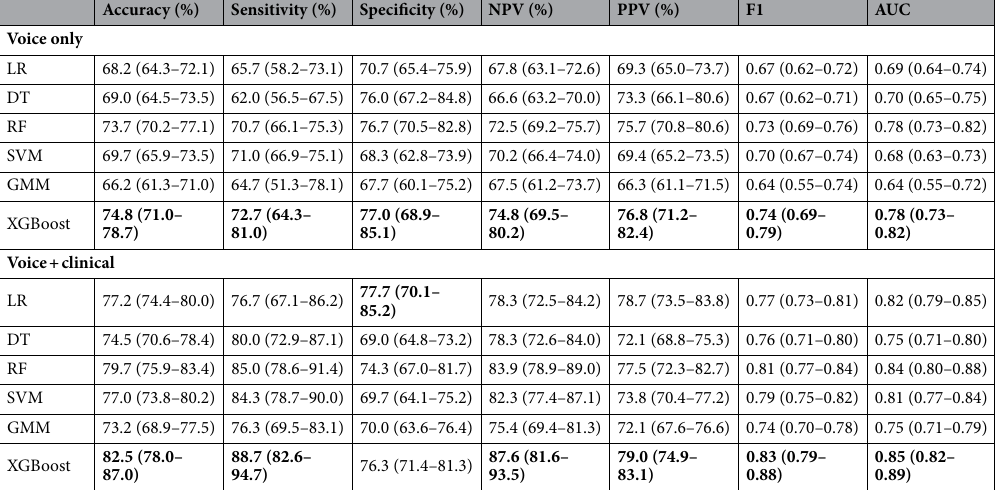
Table 3. Evaluation metric table of samples for voice signals in classifying tube feeding. Values are presented in mean (95% confidence interval). Values with bold-text represent the highest values among the models. NPV negative predictive value, PPV positive predictive value, AUC area under curve, LR logistic regression, DT decision tree, RF random forest, SVM support vector machine, GMM Gaussian mixture model, XGBoost extreme gradient